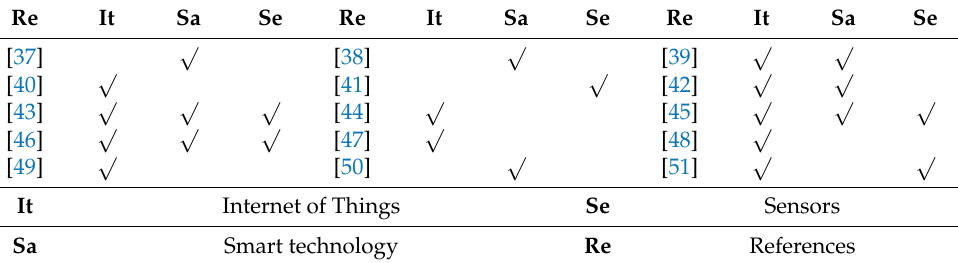
Table 3. Application of blockchain with IoT, smart technology, and sensors in